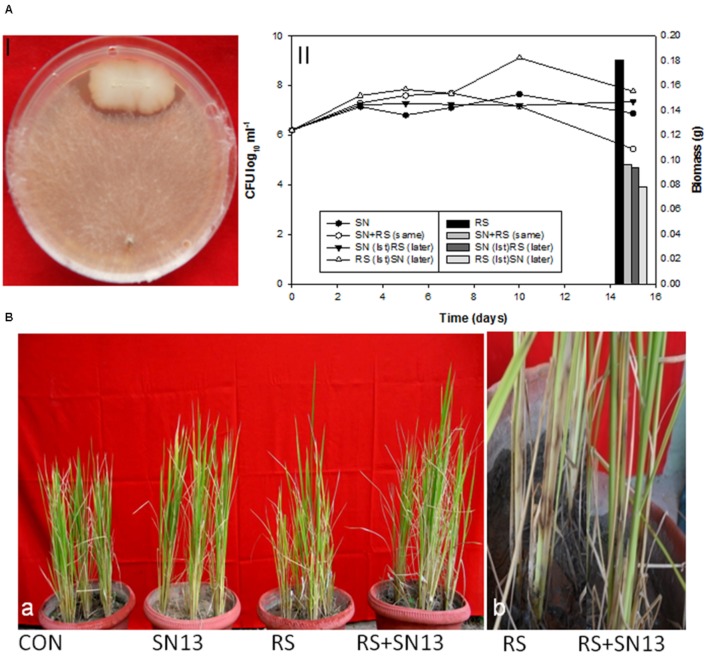
(A) Biocontrol efficacy of Bacillus amyloliquefaciens (SN13) against Rhizoctonia solani (R. solani) in dual culture method (I) and broth conditions (II) (primary axis) SN13 growth, (secondary axis) R. solani biomass. (B) Effect of SN13 on plant growth and biocontrol of rice sheath blight (a) 45 dpi (b) close view of lesion development in RS and SN13 + RS at 15 dpi. CON, control; SN13, biocontrol agent; R. solani, pathogen; dpi, days post infection.